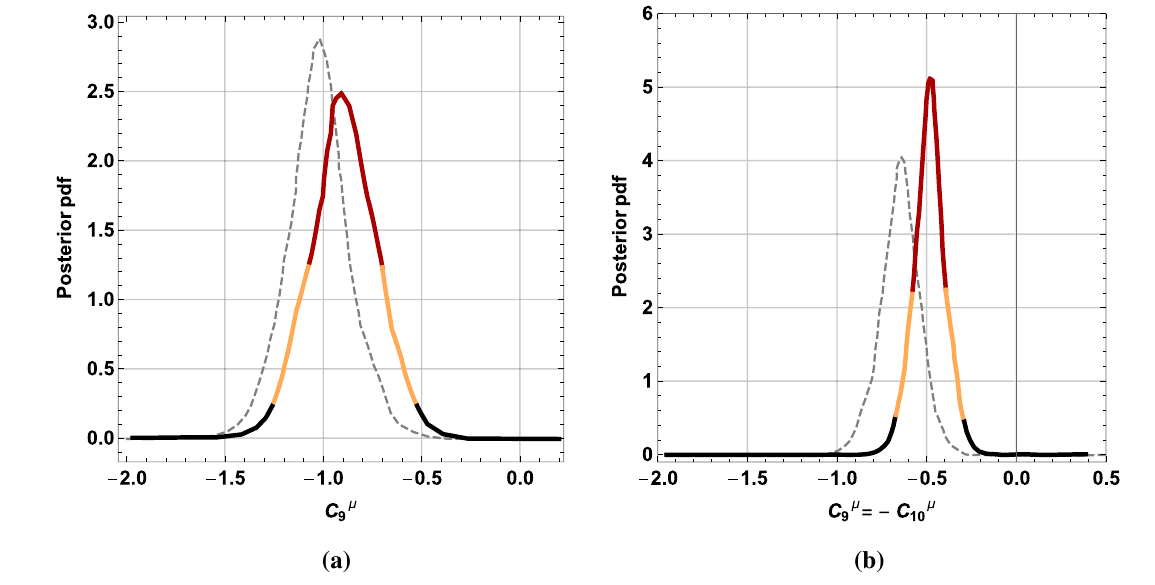
Fig. 1 a 1-dimensional posterior pdf marginalized over the nuisance parameter for the scan in the input parameter C Colorsindicatethe1 σ (red)and2 σ (orange)credibleregions.Thegray